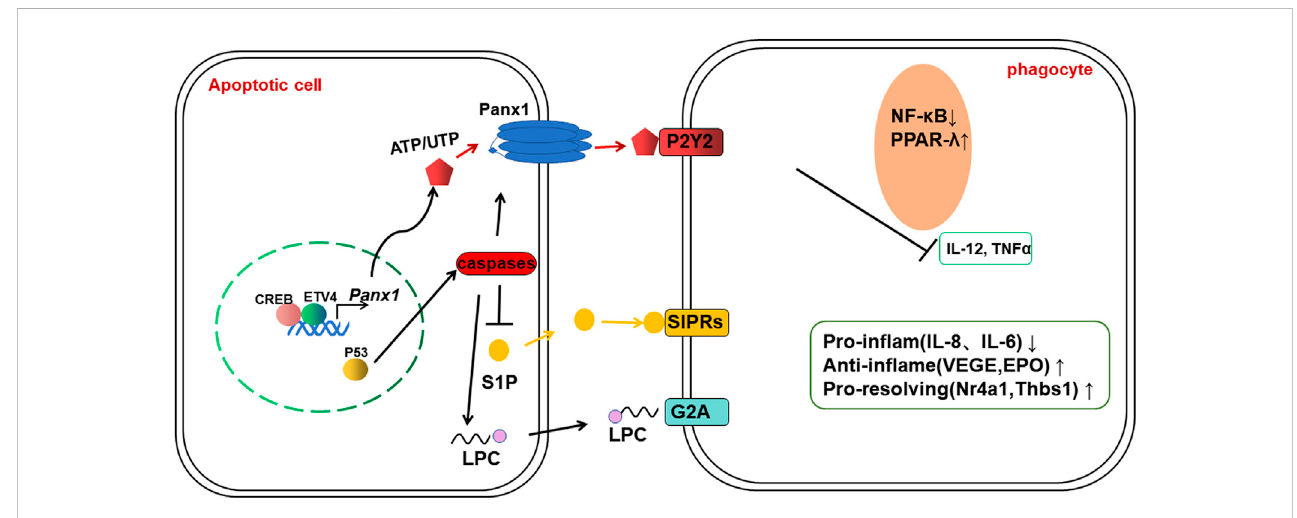
FIGURE 2 Transcription factors regulating the release and recognition of “ fi nd me ”